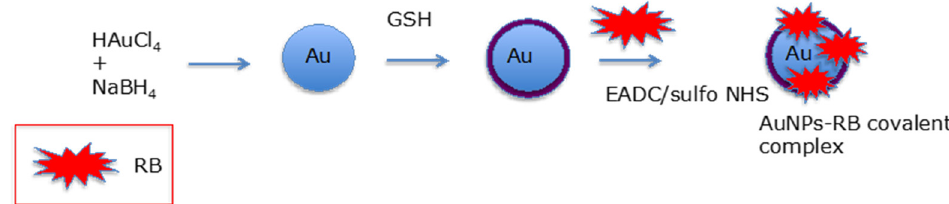
Figure 35. Preparation of Au NPs covalently coupled to RB. Adapted from Prasanna et al. [84]. The size of the AuNPs-RB electrostatic complex was 53 nm, which is similar to the covalent complex, at 49 nm. PDT experiments were performed on Vero and HeLa cell lines using white LED light (500 nm, 5 J/cm 2 ). For assays in Vero cells, free RB and electrostatic and covalent AuNPs-RB complexes presented IC 50 values of 19.53, 16.69, and 9.18 µg/mL (3 h), respectively. These values were 16.99, 14.47 and 8.24 µg/mL in HeLa cells. The AuNPs-RB complexes were more toxic than free RB, and the covalent complex was more toxic than the electrostatic complex.